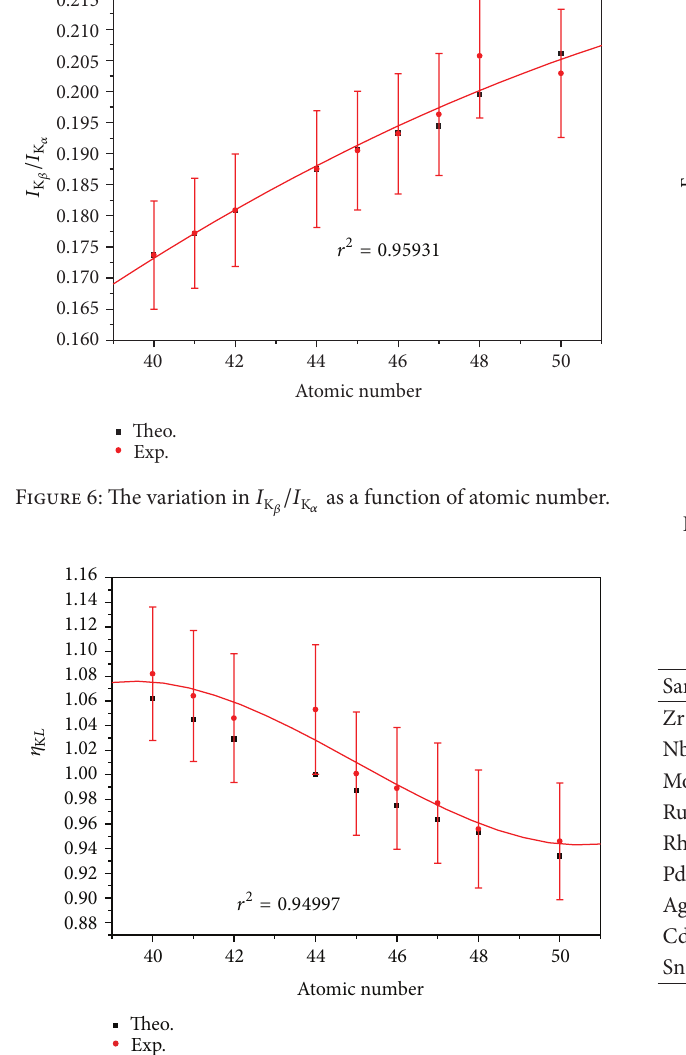
Table 6: K shell Γ